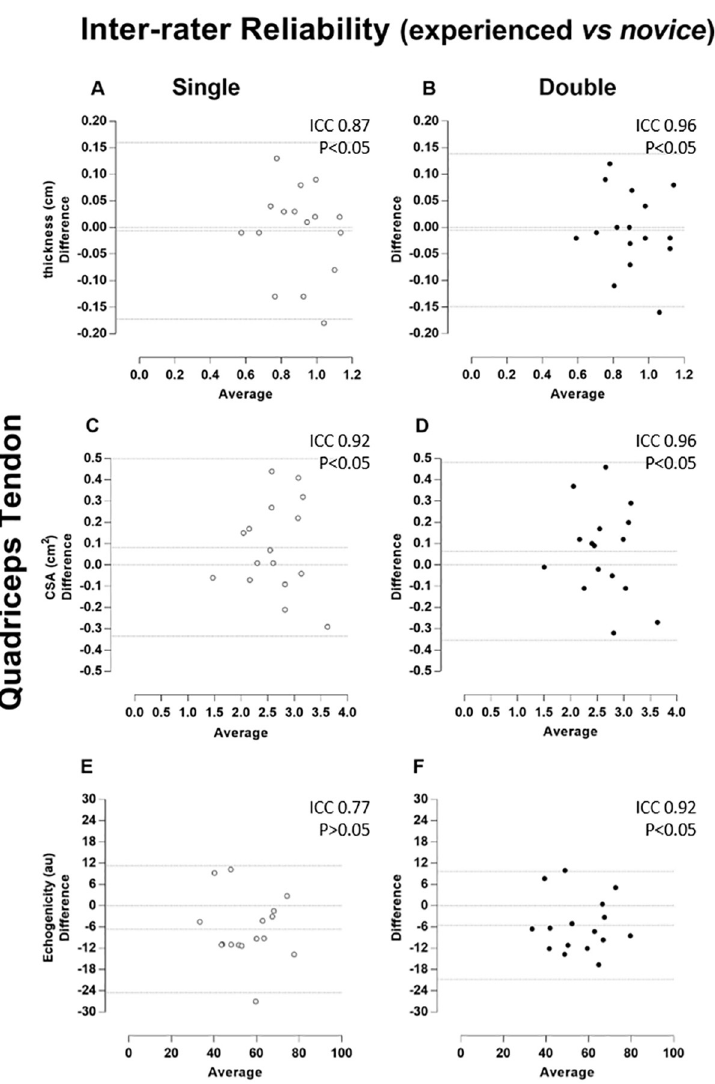
sectional area (CSA, C and D), and echogenicity (E and F) on the quadriceps tendon. The single and double measures are respectively in the left (A, C, and E) and (B, D, and F) right columns and plotted by white and black circles. Besides the zero line, the bias line and random error lines forming the 95% limits of agreement are presented by dashed lines.